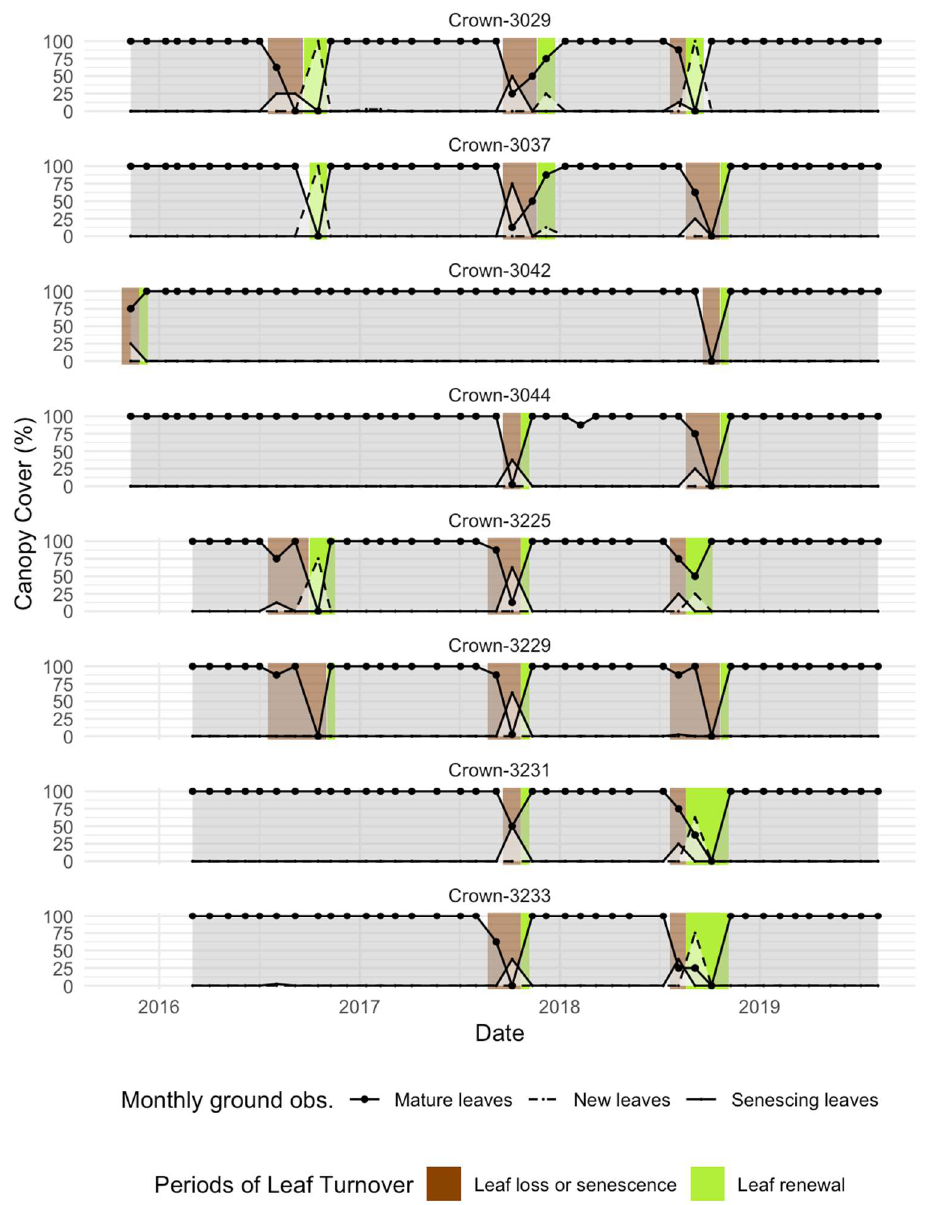
Figure 2. Ground observations of Moabi leaf turnover at Lopé NP, Gabon (2015-2019). The solid and dashed lines show the scores given for canopy coverage of mature, senescing, and new leaves at each monthly observation. The brown and green rectangles show the likely periods of either leaf senescence and loss (brown rectangles) or leaf renewal (green rectangles) based on the monthly observations as defined in Figure 1.